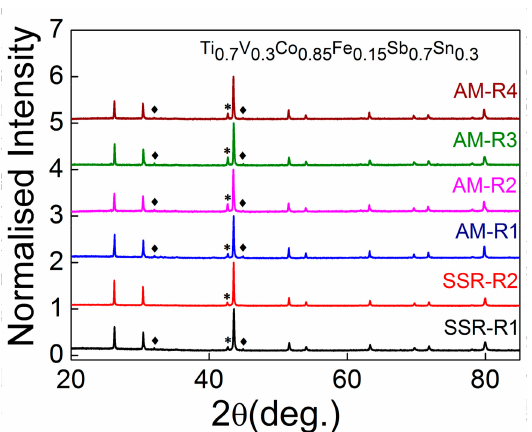
Figure 1. X-ray powder diffraction patterns for the Ti 0.7 V 0.3 Co 0.85 Fe 0.15 Sb 0.7 Sn 0.3 samples prepared using powder metallurgy (SSR) and arc melting (AM). Secondary phases are labelled as *: FH and (cid:7) : Sn.